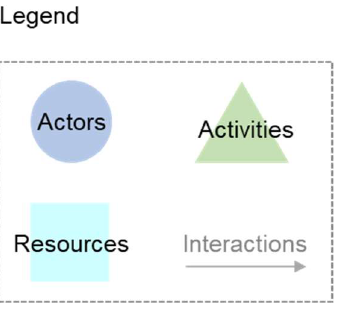
Fig. A3.2. Individual mental models of eight members of La Palma fishing